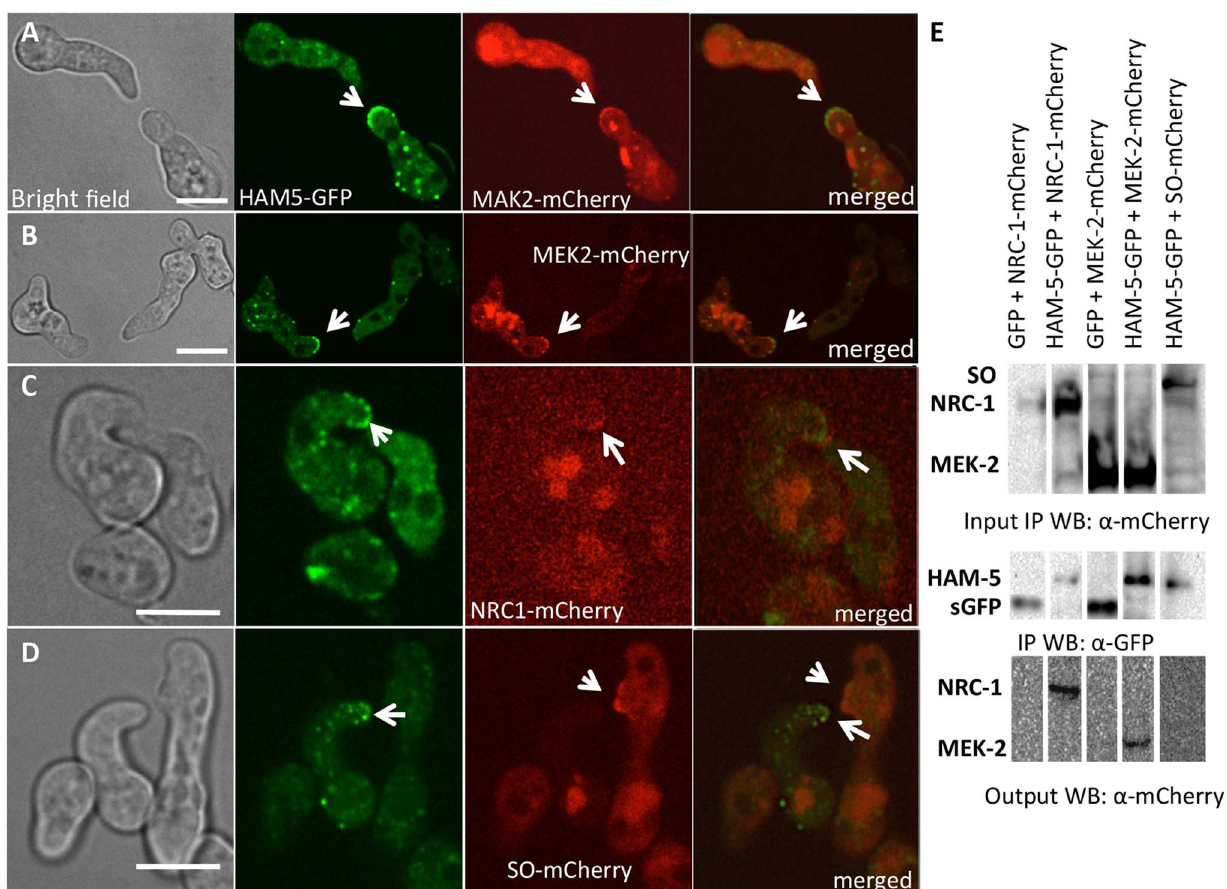
Figure 3. HAM-5-GFP shows localization with components of the MAK-2 pathway. (A) Co-localization of HAM-5-GFP and MAK-2-mCherry during germling communication (arrows). (B) Co-localization of HAM-5-GFP and MEK-2-mCherry during germling communication (arrows). (C) Co- localization of HAM-5-GFP and NRC-1-mCherry during germling communication. NRC-1-mCherry strains show low fluorescence [18]. (D) HAM-5-GFP and SO-mCherry do not co-localize during chemotropic interactions, but instead show opposite localization to CAT tips in communicating germlings (arrows). The images on the left are bright field images, fluorescent images on the right. Scale bar =10 m M. (E) Co-immunoprecipitation experiments showing an interaction between HAM-5-GFP (210 kD; Figure S4D) and MEK-2-mCherry (82.9 kD; Figure S4C) and NRC-1-mCherry (128 kD; Figure S4C). Input panels show Western blots of immunoprecipitated protein samples from 5 hr-old germlings probed with either anti-GFP (free GFP =27 kD; Figure S4D) or anti-mCherry antibodies. The output panel is a Western blot of proteins immunoprecipitated by anti-GFP antibodies (and thus HAM-5- GFP) and probed with anti-mCherry antibodies (detecting MEK-2-mCherry or NRC-1-mCherry).